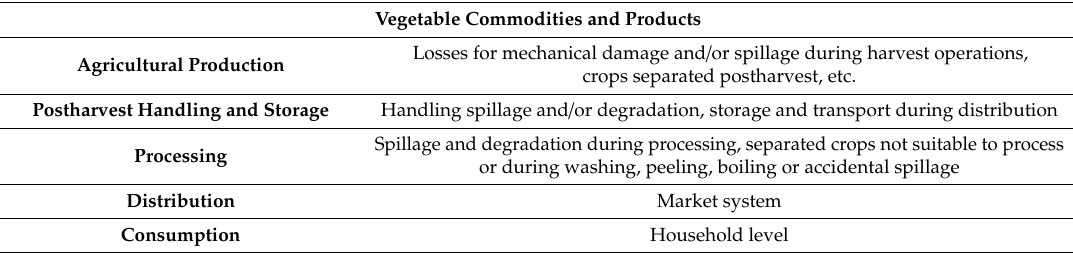
Table 1. Five system boundaries in the food supply chain (adapted from